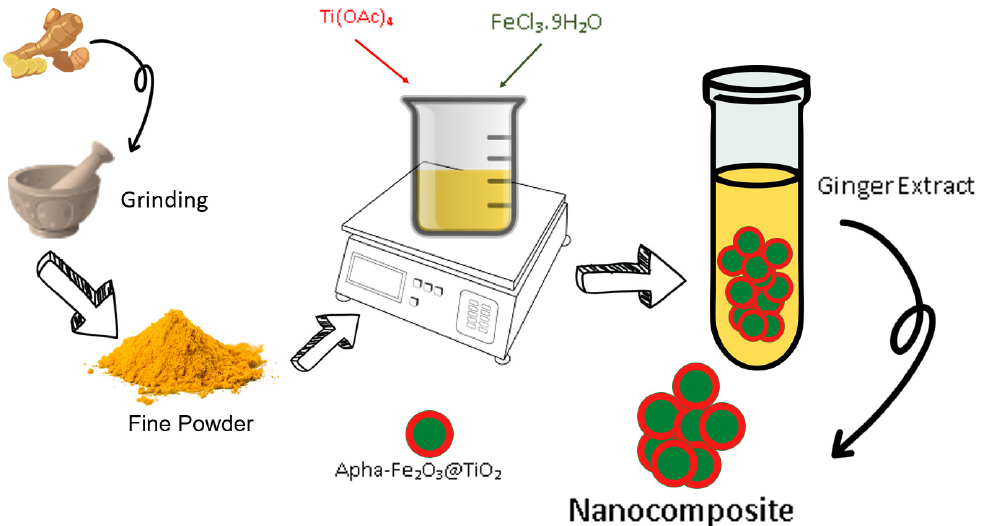
Figure 1. Schematic diagram of the green synthesis of α -Fe 2 O 3 @TiO 2 nanocomposites.